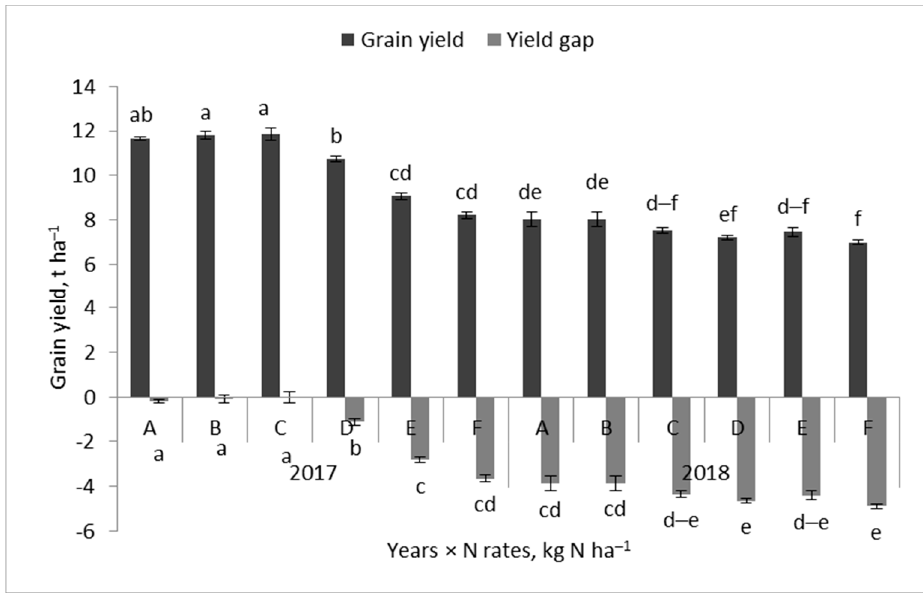
Figure 2. Effect of plant protection methods on the grain yield and yield gap of winter wheat. Similar letters indicate a lack of significant differences between experimental treatments using Tukey’s test. The vertical bar in the column is the standard error of the mean.